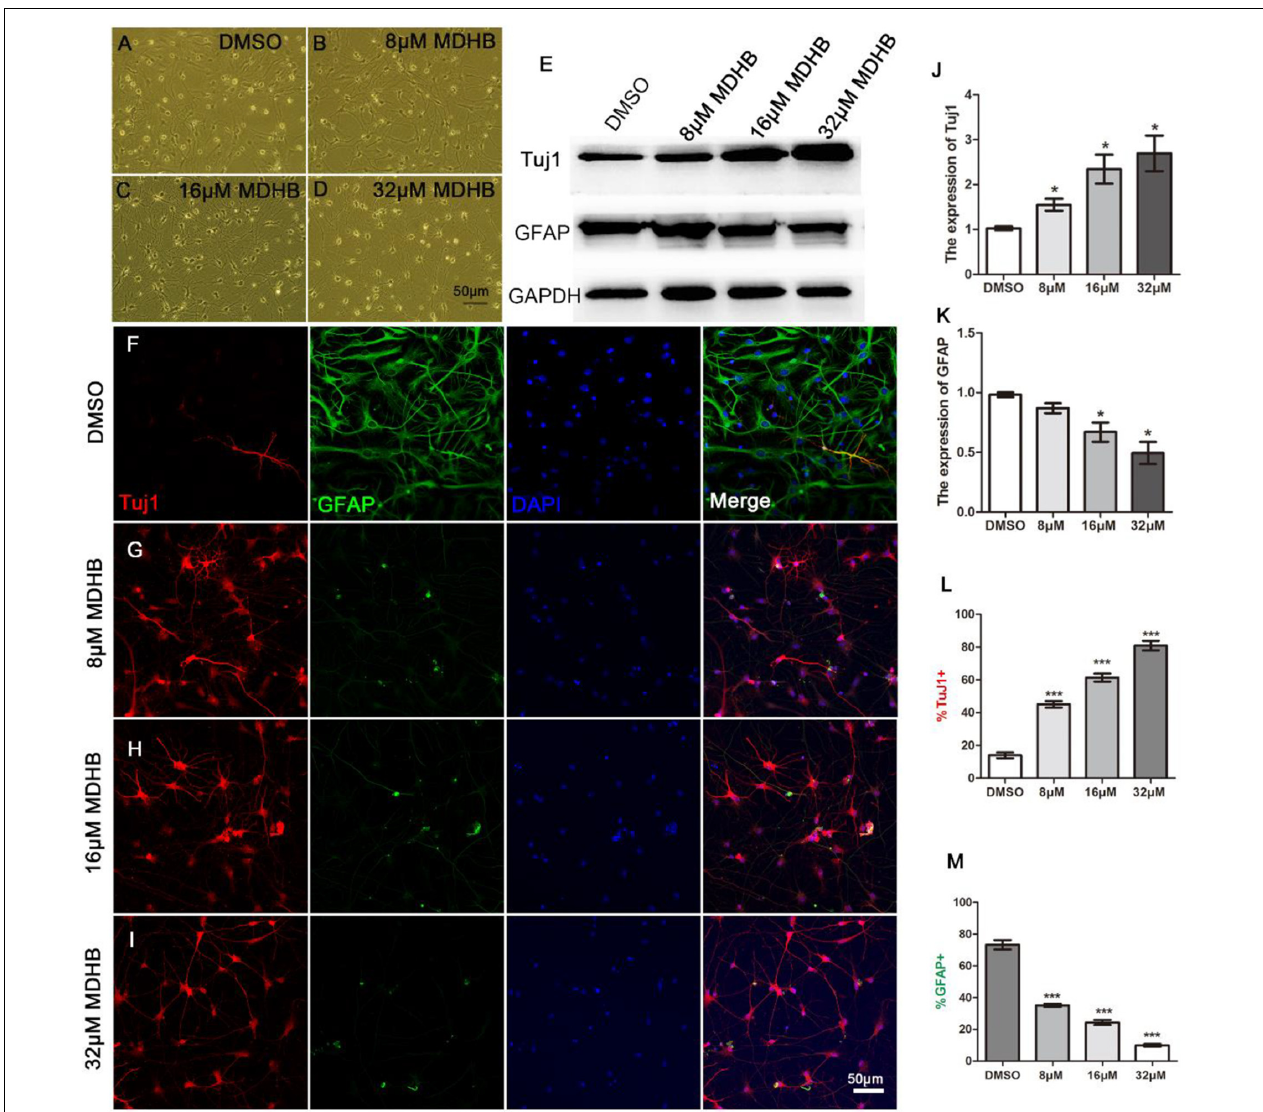
FIGURE 2 | MDHB promotes NSCs differentiation into neurons. (A) The solvent control group (DMSO); (B–D) Low dose (8 µ M MDHB), middle dose (16 µ M MDHB), and high dose (32 µ M MDHB) groups. (E) Western blot analysis for Tuj1 (immature neuron) and GFAP (astrocyte) on differentiation of NSCs. (F–I) After 5 days of NSCs differentiation induced by MDHB, new cells were fluorescently stained, the cells with neuronal marker Tuj1 were dyed red; with glial marker GFAP dyed green; and all cell nuclei with nuclear marker DAPI were dyed blue. (J,K) Quantification of protein blots is shown, GAPDH serves as protein loading control. (L) The statistical results of neurons differentiated by MDHB-induced NSCs. (M) The statistical results of astrocytes differentiated by MDHB-induced NSCs ( ∗ P < 0.05, ∗∗∗ P < 0.001, compared with DMSO group, n =